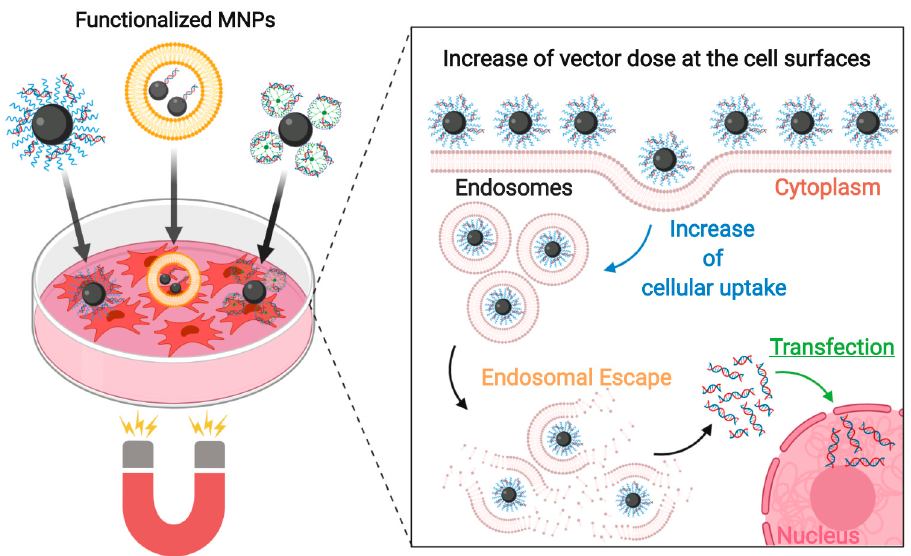
Figure 12. Schematic of the magnetofection principle. Under the effect of a magnetic field, functionalized IONs are guided directly to target cells. This generates an increase in the vector availability at the cell surfaces that leads to an increase in cellular uptake. Endosomal escape occurs by the action of the specific molecules used to functionalize IONs. High transfection rates can be achieved: More nucleic acids loaded IONs into the cytoplasm leads to an increase of free nucleic acids generating more efficient transfection rates. (Created with BioRender.com).